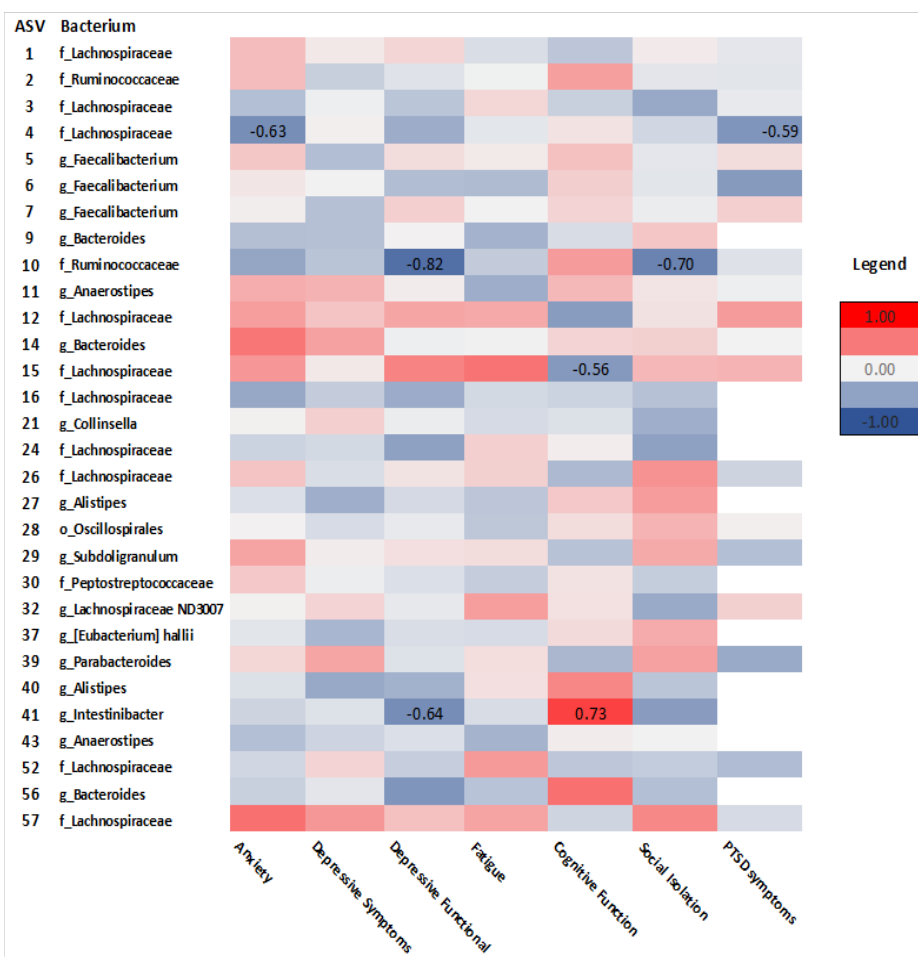
Figure 7. Heatmap of correlations between psychosocial outcomes and ASVs at the order (o), family (f), and genus (g) levels in cancer survivors. Spearman’s rho is presented. (Values for n range from 10–17.)